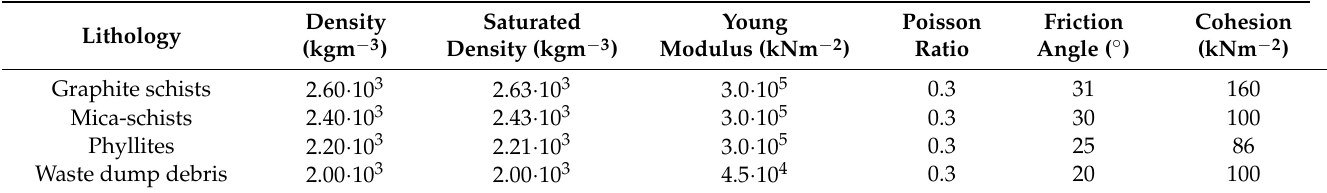
Table 1. Geo-mechanical properties of dominant lithologies (adapted with permission from ref. [28]).